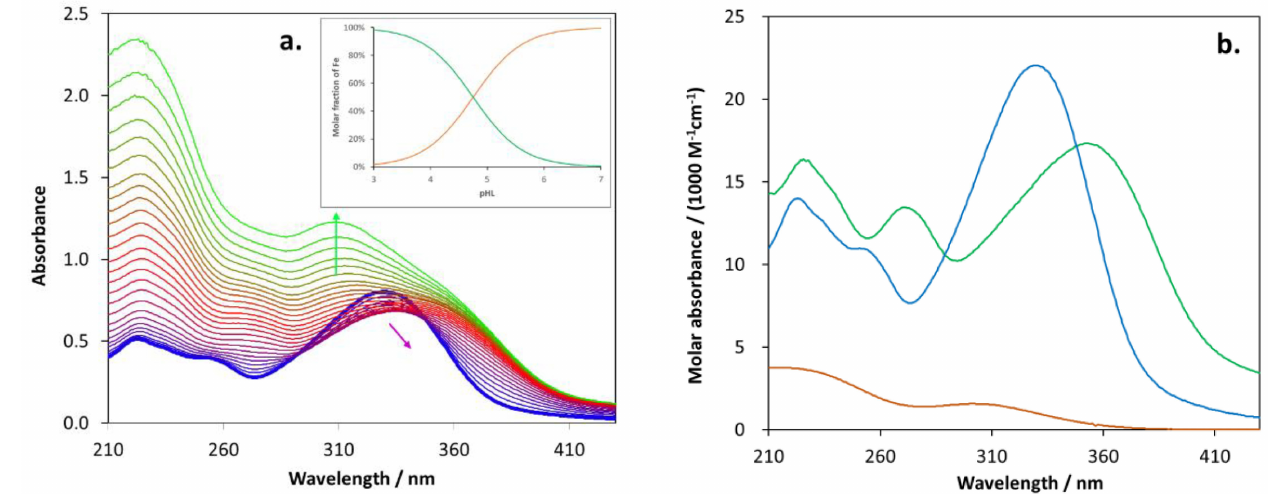
Figure 12. The measured absorption spectra ( a ) at constant total ligand ( trans - 6 ) concentration (3.5 · 10 − 5 M) and various Fe 3+ total concentration (from 0 M (blue) to 4.7 · 10 − 4 M (green)). The inset shows the molar fraction of free Fe 3+ (orange) and 1:1 complex (FeL 2+ ) (green) as functions of the protonated ligand concentration (pHL). Subfigure ( b ) shows the molar absorbance of Fe 3+ (orange), ligand (blue), and FeL 2+ adduct (green).